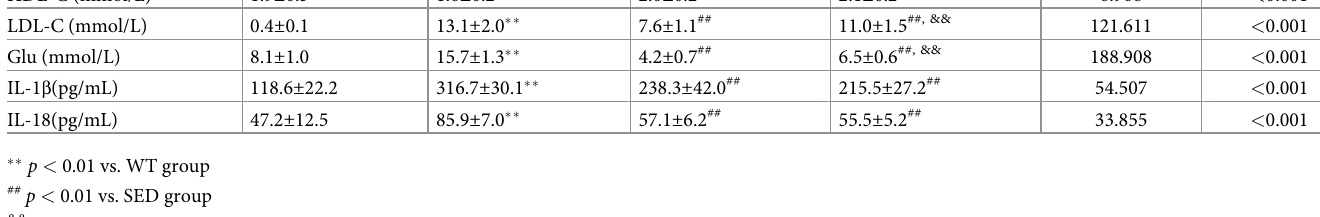
filling the entire blood vessel lumen. In contrast, the extent of intra-aortic plaque lesions in the EX-1h and EX-24h groups were significantly reduced compared with the SED group (Fig 2C).